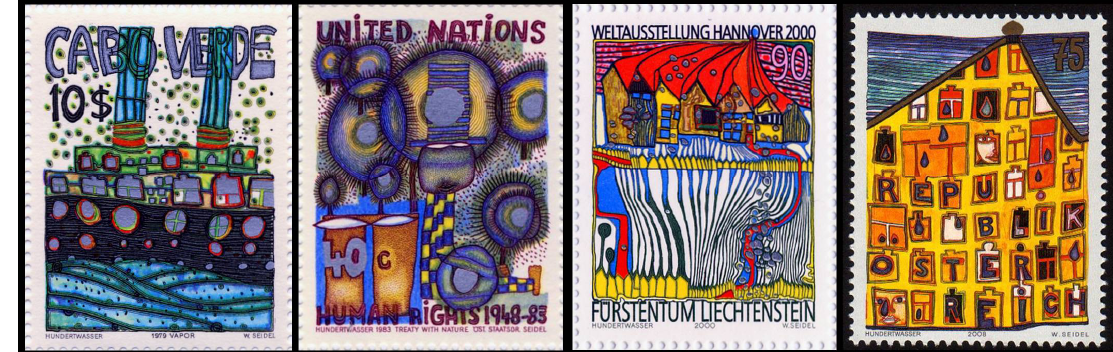
Figure 1. Hundertwasser’s stamps.